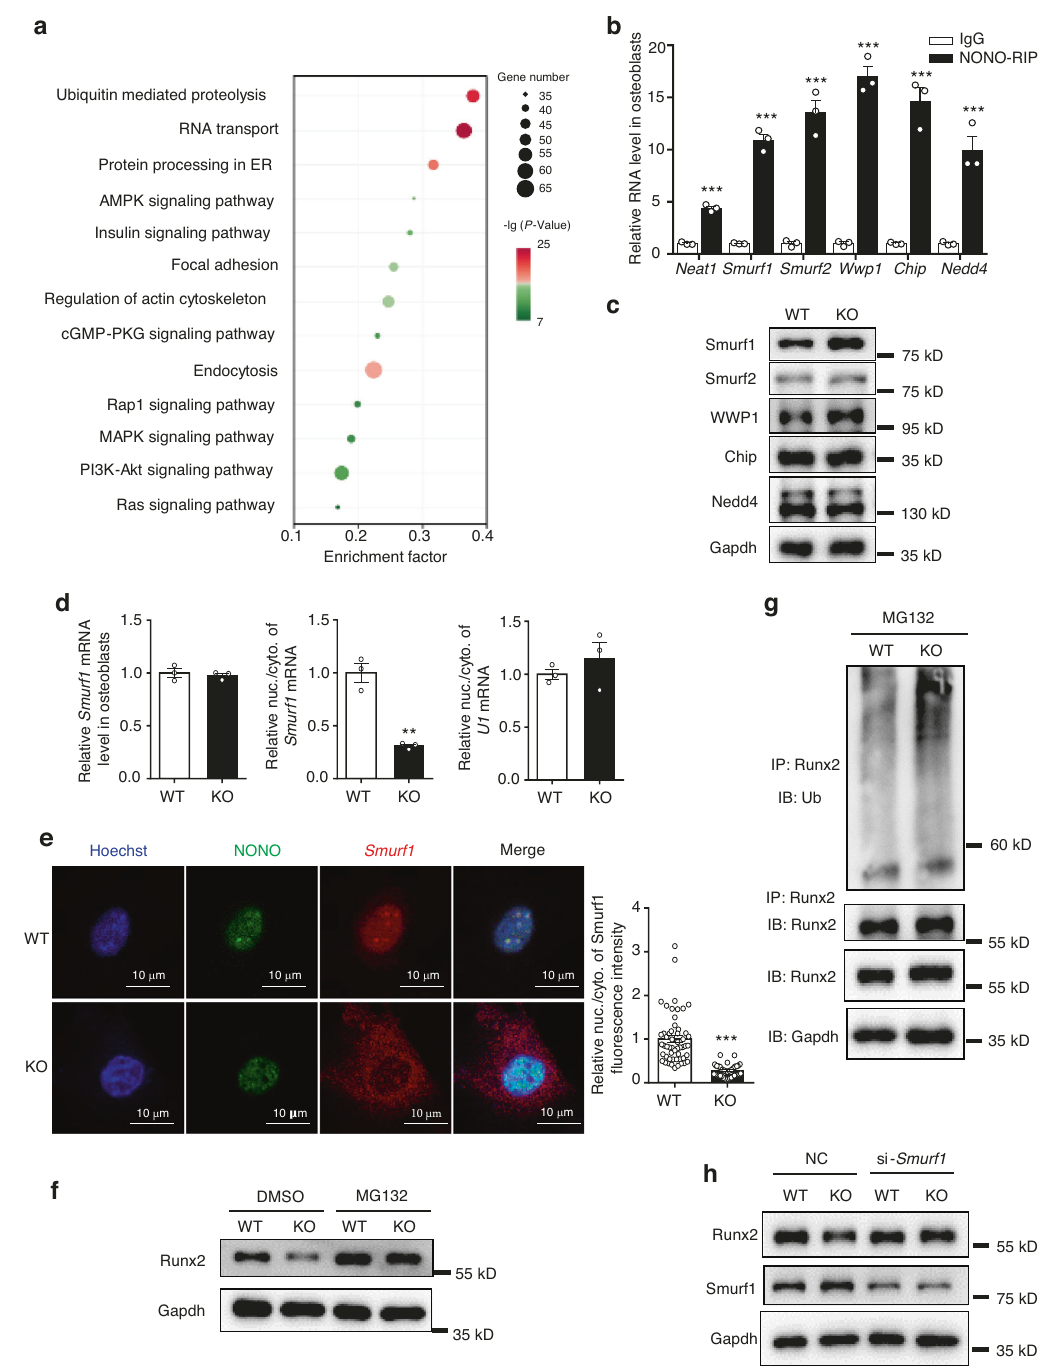
Fig. 4 Identi fi cation of Neat1 -interacting mRNA and the nuclear retention of Smurf1 in osteoblasts. a KEGG signaling pathway enrichment analysis of genes in osteoblasts after RIP-Seq. n = 3 of each group. b Enhanced enrichment of candidate E3 ubiquitin ligase mRNA revealed by native NONO immunoprecipitation in osteoblasts. Data are presented as the mean ± s.e.m. from three independent experiments. c Protein levels of candidate E3 ubiquitin ligases were detected in the WT and Neat1 -KO osteoblasts. The experiment was repeated for more than three times. d Quantitative PCR showed no changes in total Smurf1 mRNA between the WT and Neat1 -KO osteoblasts. Enhanced nucleocytoplasmic export of Smurf1 mRNA was shown in Neat1 -KO osteoblasts. U1 was used as a negative control for the nuclear and cytoplasmic ratios. The results are presented as the mean ± s.e.m. from three independent experiments. e Representative image of Smurf1 RNA FISH in the WT and Neat1 -KO osteoblasts. The quantitative data of Smurf1 nuclear/cytoplasmic fl uorescence distribution are presented on the right of the image. f Neat1 participates in the process of Runx2 degradation by the proteasome pathway. The WT and Neat1 -KO osteoblasts were isolated and treated with 5 μ mol·L − 1 MG132 or DMSO for 6 h. The experiment was repeated three times. g The WT and Neat1 -KO osteoblast lysates were immunoprecipitated with anti-Runx2 antibody. Mouse primary osteoblasts were treated with 5 μ mol·L − 1 MG132 for 6 h. Ubiquitination levels were analyzed by western blotting. Representative results of three independent experiments are shown. h Western blotting showed increased Smurf1 protein levels in the Neat1 -KO osteoblasts, and knockdown of Smurf1 blocked the downregulation of Runx2 expression induced by Neat1 de fi ciency. Representative results of three independent experiments are shown. * P < 0.05, ** P < 0.01, *** P <